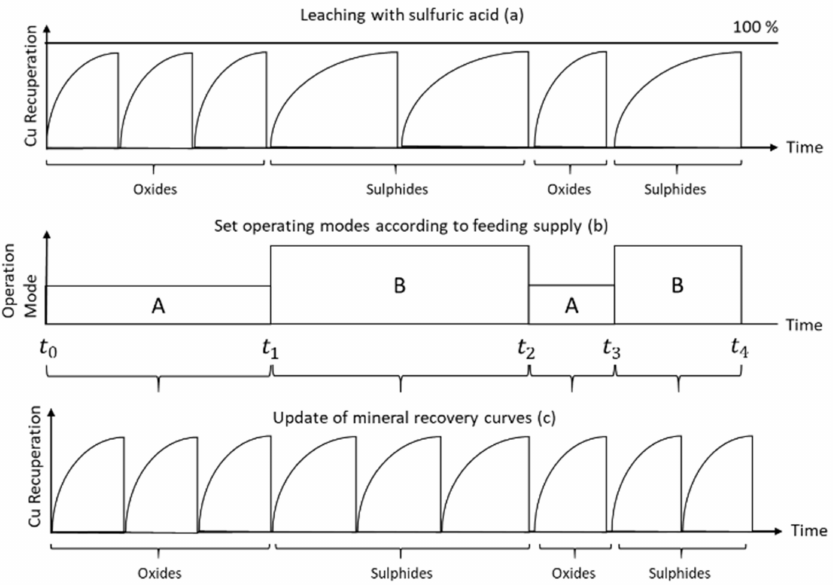
Figure 1. Proposal to improve copper recovery through variation in operating modes. Leaching of oxidized minerals and copper sulfides using only H 2 SO 4 as the leaching agent ( a ), configuration of operating modes (Modes A and B) according to mineral feed ( b ), and updating of operating curves in the event of variation in leaching agents ( c